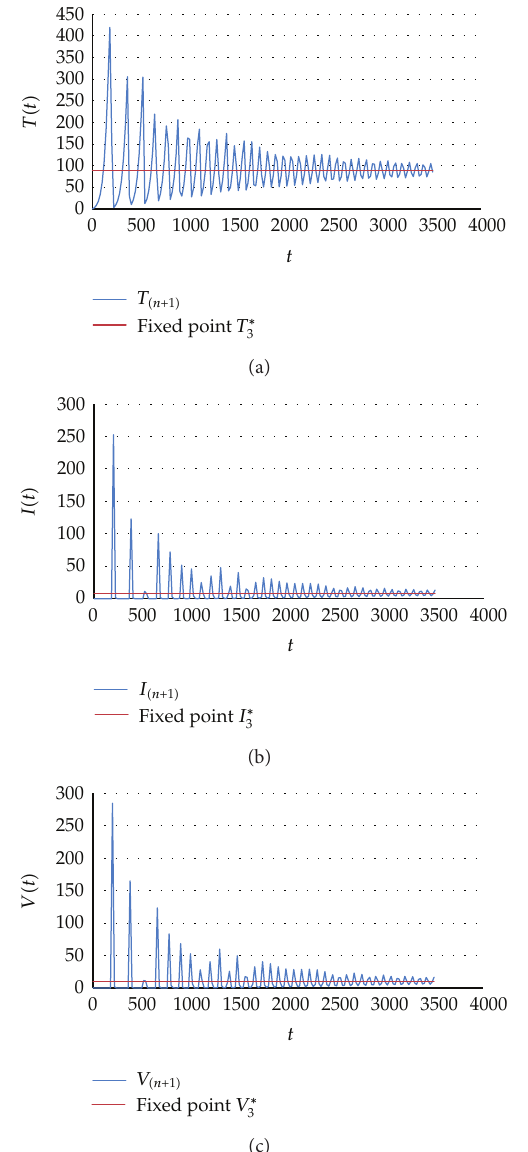
Figure 1: NFDS solutions for 𝑇(𝑡) , 𝐼(𝑡) , and 𝑉(𝑡) , 𝑟 = 0.05 .